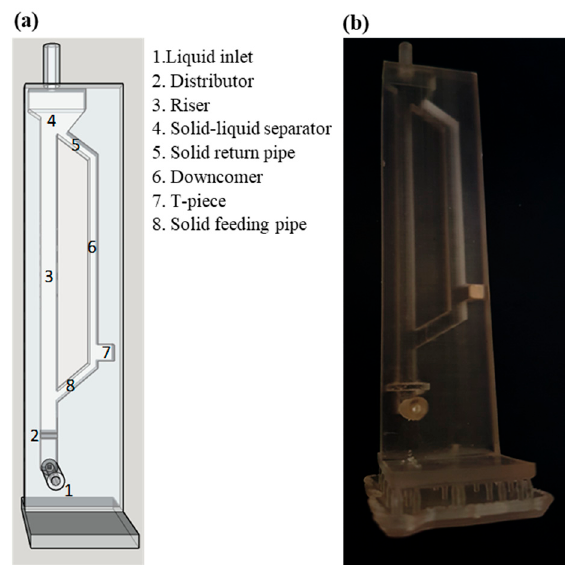
Figure 2. ( a ) Exploded CAD model of micro-circulating fluidised bed design; ( b ) 3D printed micro- circulating fluidised bed. micro-circulating fluidised